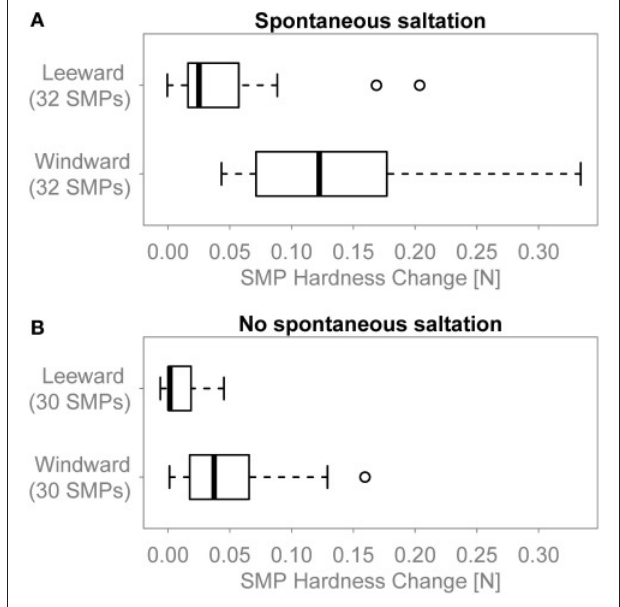
FIGURE 6 | Boxplots comparing SMPs that were acquired either on the windward or the leeward side of the obstacle during experiments where (A) saltation started spontaneously or (B) saltation could only be achieved by sieving snow into the wind